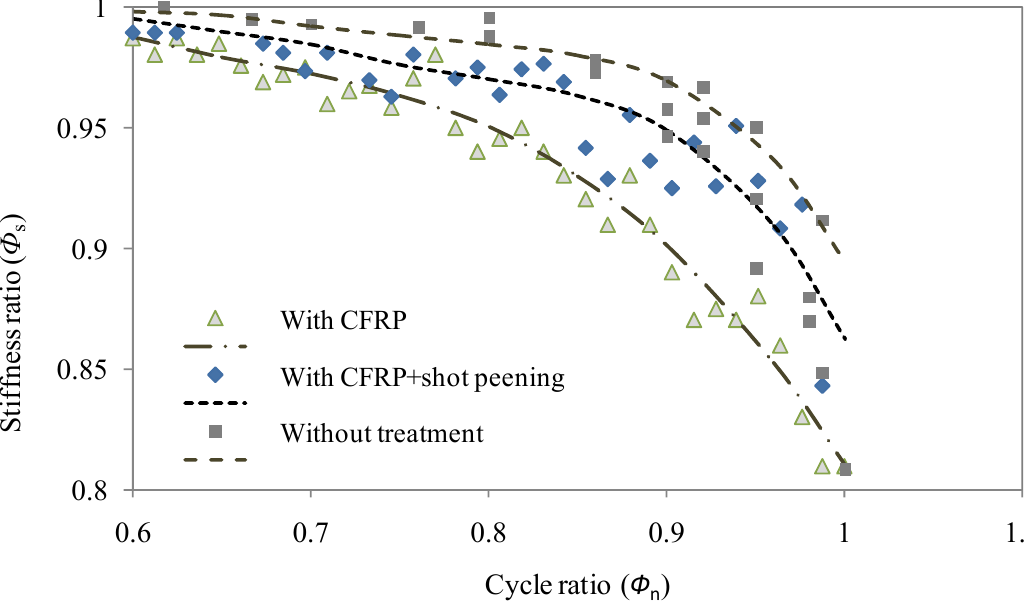
Figure 5. Comparison of relations between stiffness ratio and cycle ratio.